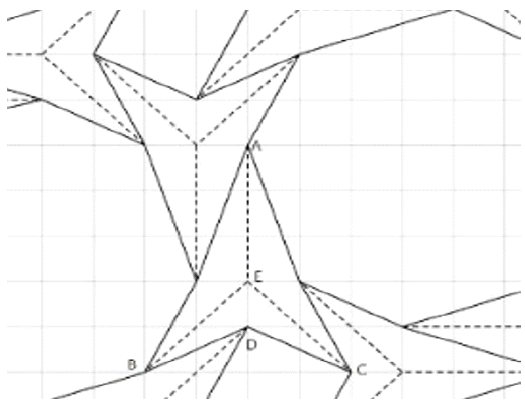
Figure 3. The third ornamentation. Figure 4. The fourth ornamentation.